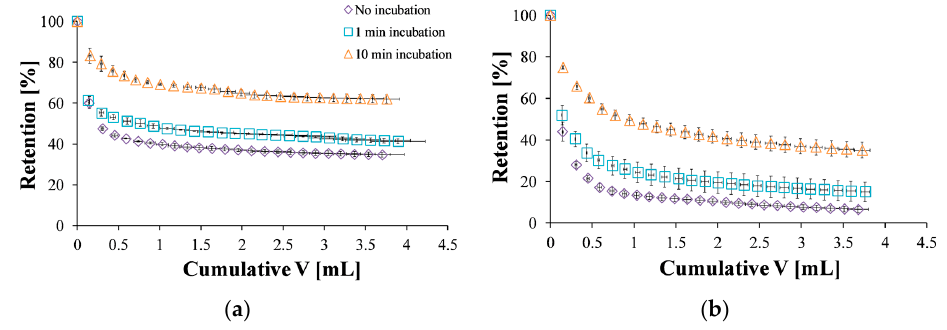
Figure 5. Retention profile of: ( a ) ACS nanoparticles without incubation (purple diamond), one minute of incubation (blue square), and ten minutes of incubation (orange triangle); ( b ) CS nanoparticles without incubation (purple diamond), one minute of incubation (blue square), and ten minutes of incubation (orange triangle).